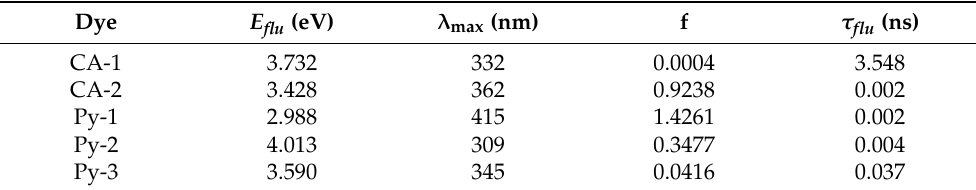
Table 3. Calculated TD-M11 fluorescence energies E flu , fluorescence wavelengths λ emi , oscillator strengths (f) and radiative